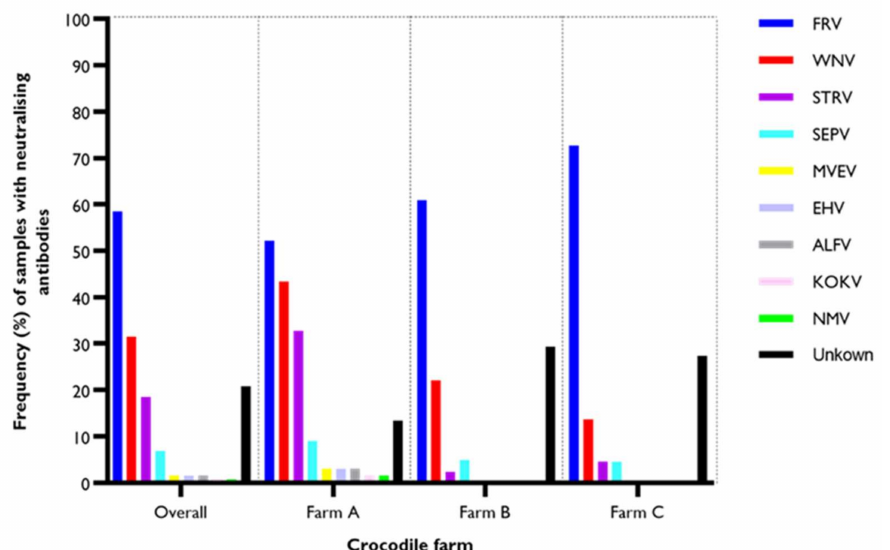
Figure 3. Proportion of samples positive in the 6B6C-1 blocking ELISA that have neutralising antibodies against tested flaviviruses. The overall frequency was determined based on n = 130. The frequency per farm was estimated based on n = 67 at Farm A, n = 41 at Farm B, and n = 22 at Farm C.